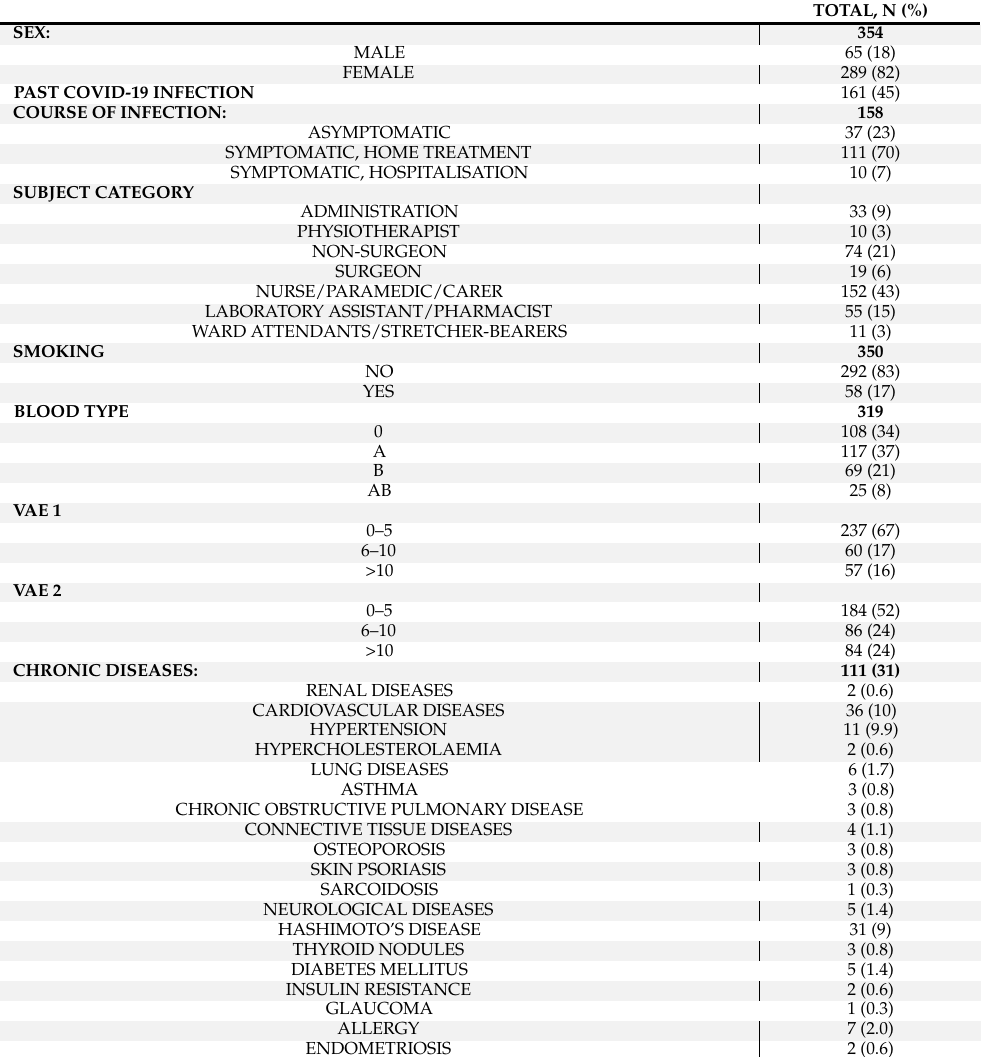
Table 1. Characteristics of the study group of hospital